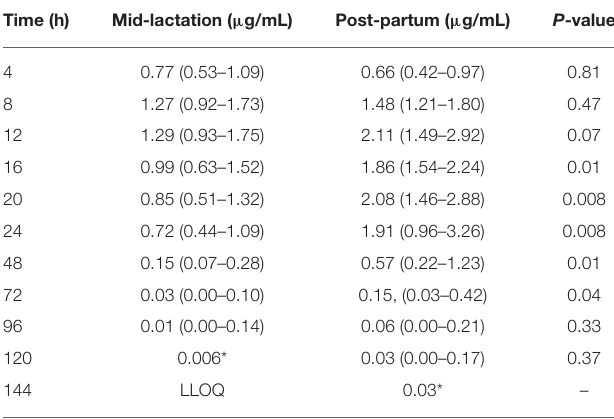
TABLE 3 | Plasma concentrations ( µ g/mL) for meloxicam from six post-partum cows compared to mid-lactation cows that received oral administration of a single dose of meloxicam at 1.0